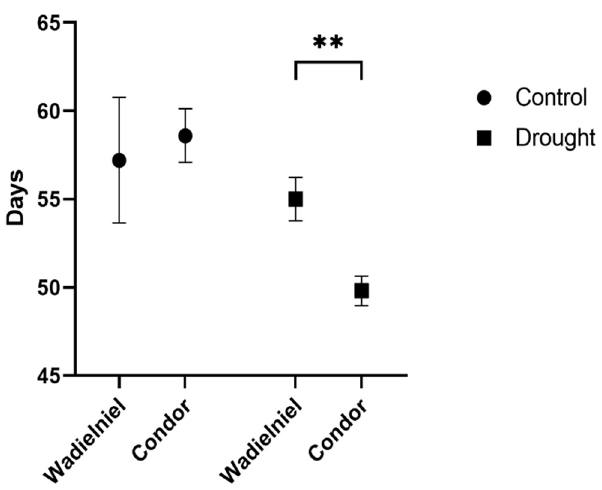
Figure 2. Days of heading for both cultivars in control and water limitation condition as inferred from pictures. Bars show mean ± SD. Statistical significances are determined by a Student t -test between cultivars in the same experimental conditions ** p < 0.01.